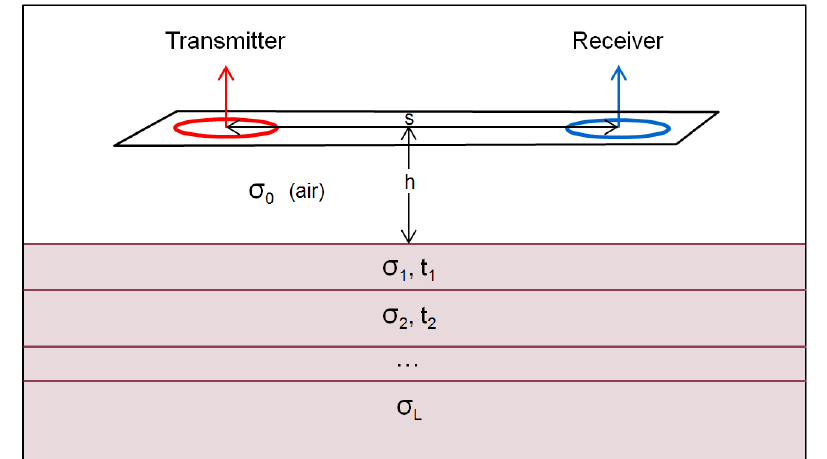
Figure 3. Geometry of the horizontal coplanar electromagnetic sensor over layered earth where σ is the conductivity, t is the thickness of each layer, the subscripts stand for the number of layers, s is the coil separation and h is the sensor height [30].